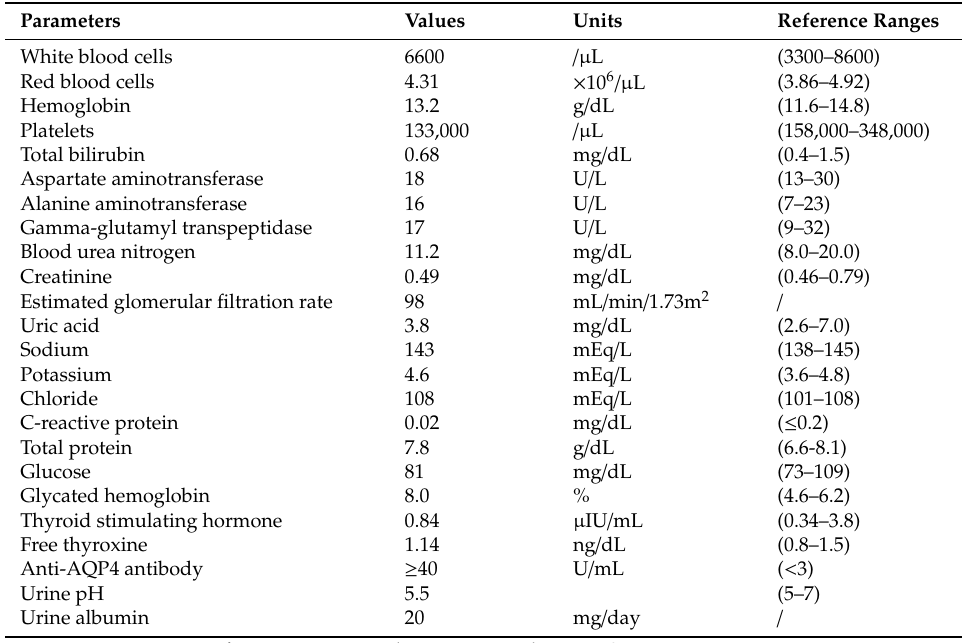
Table 1. Laboratory parameters on admission.